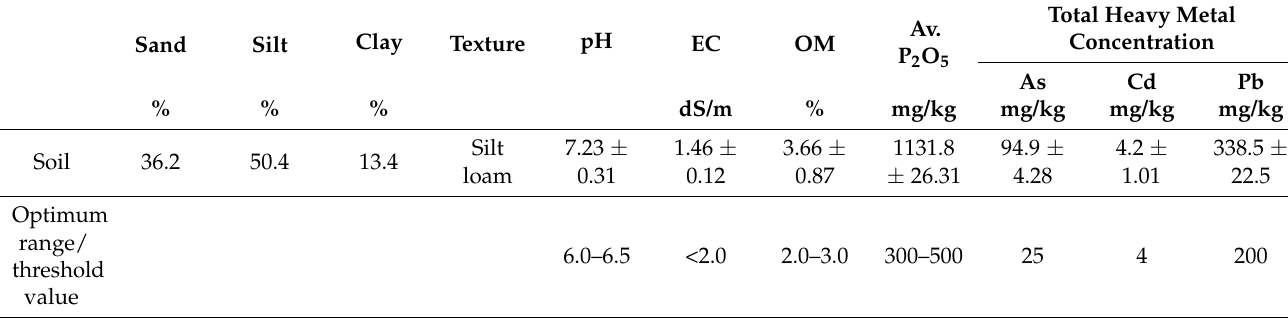
Table 2. Physicochemical properties and total heavy metal concentration in the soil.